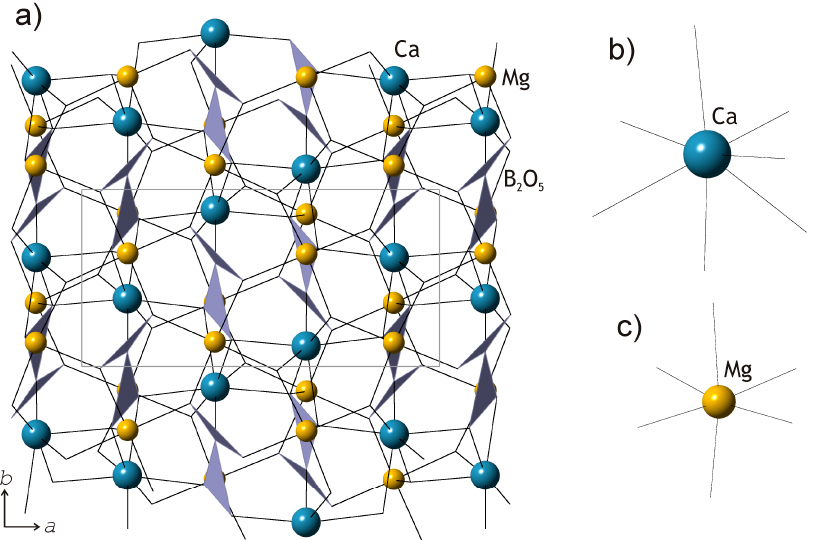
Figure 3. The structure topology of the 6 Å-block in the crystal structures of kurchatovite and clinokurchatovite ( a ; the picture corresponds to one of the symmetrically independent blocks in kurchatovite) and the coordination figures of Ca ( b ) and Mg ( c ) atoms.